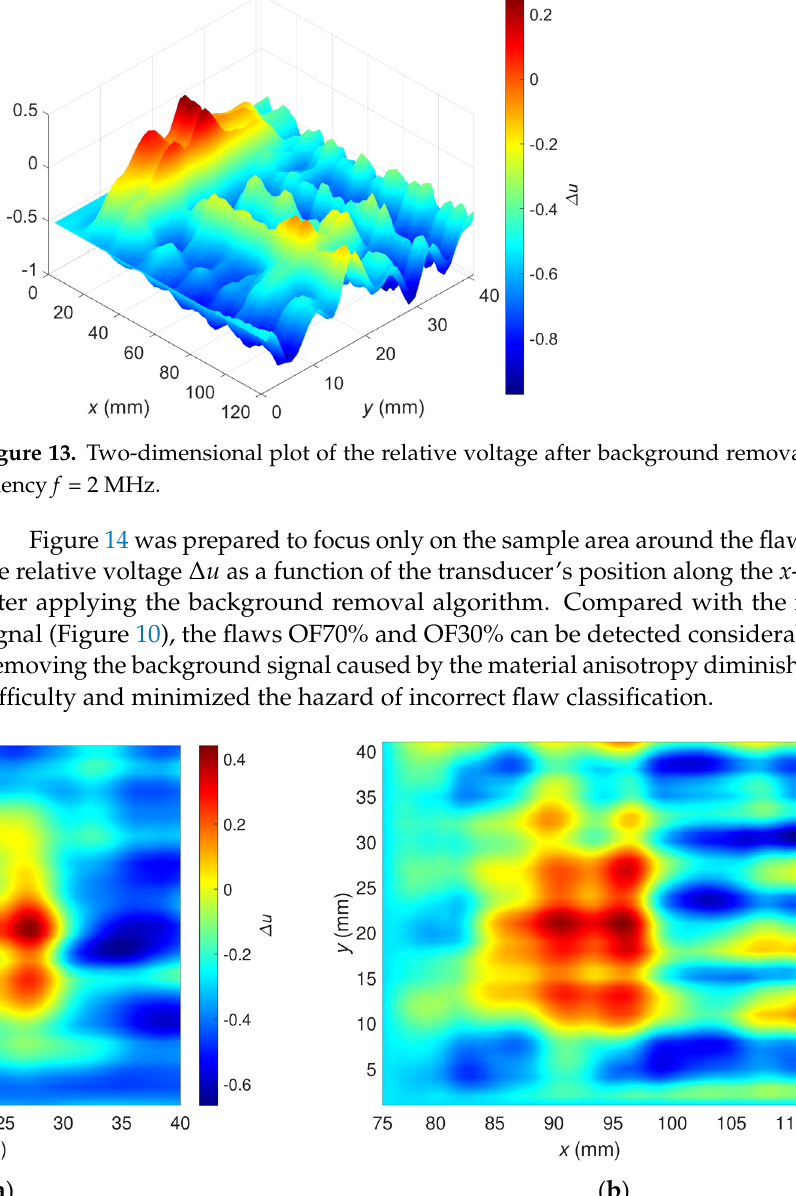
10 of 13 Figure 11. Signal processing algorithm for the background signal removal. ( a ) ( b ) Figure 12. Two-dimensional plots of the background signals estimated for the excitation frequency f = 2 MHz, which were utilized to correct signals measured for the flaw: ( a ) OF70%, ( b ) OF30%.